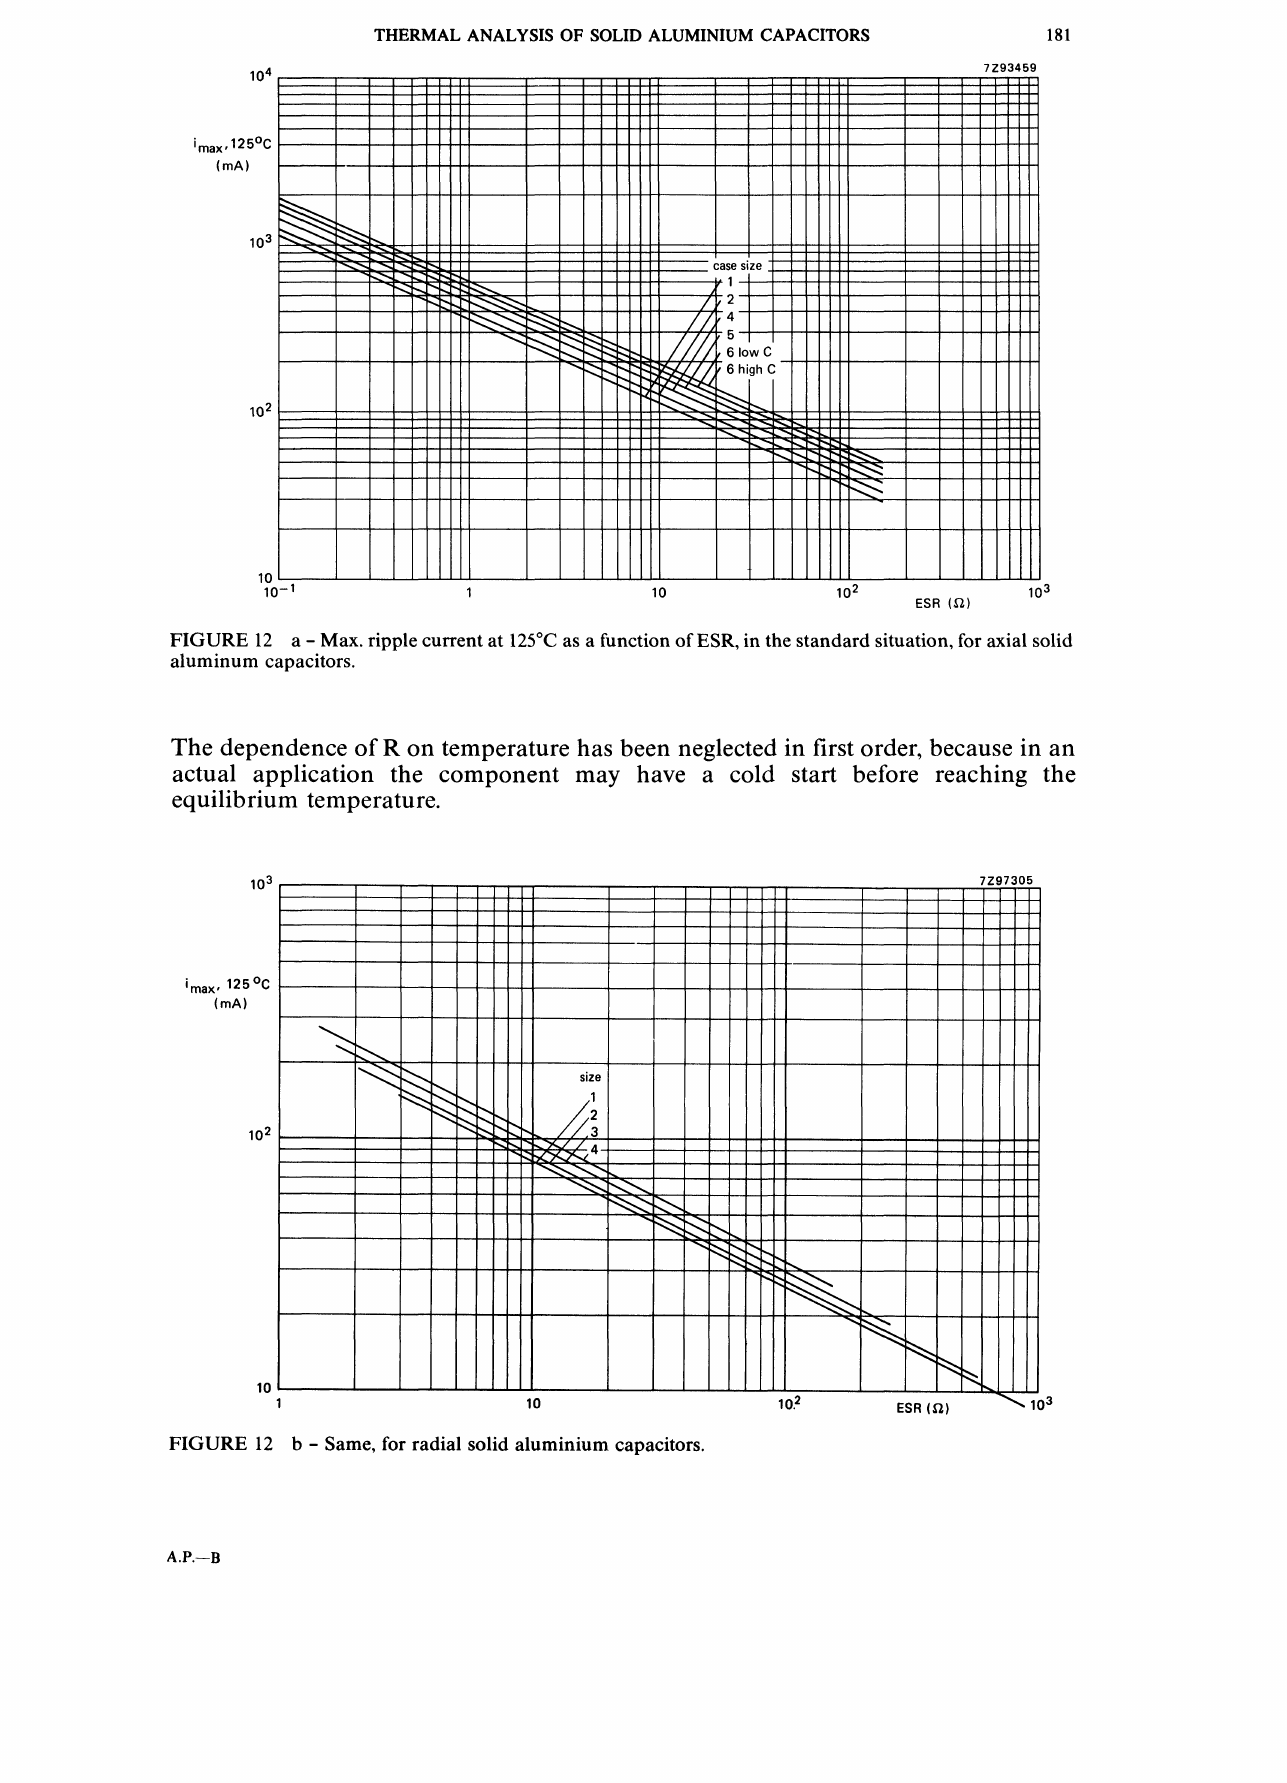
FIGURE 12 a Max. ripple current at 125C as a function of ESR, in the standard situation, for axial solid aluminum capacitors.